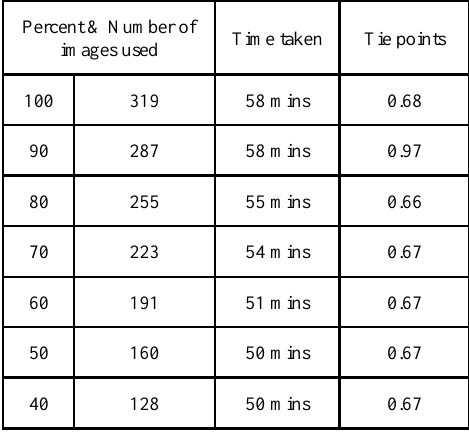
Figure 5 . Mosaic generated with 100%, 80%, 60%, 40% and 20% of aerial images acquired at a flight height of 13 m. Table 3 . Time taken to generate mosaics with different percent of aerial images acquired at a flight height of 13 m. All 241 aerial images were used for aligning and mesh building, prior to Loss of information was noticed when 40% of the images (n = generating the mosaic. 96) and there were more gaps in the mosaic generated with 20% of the images.